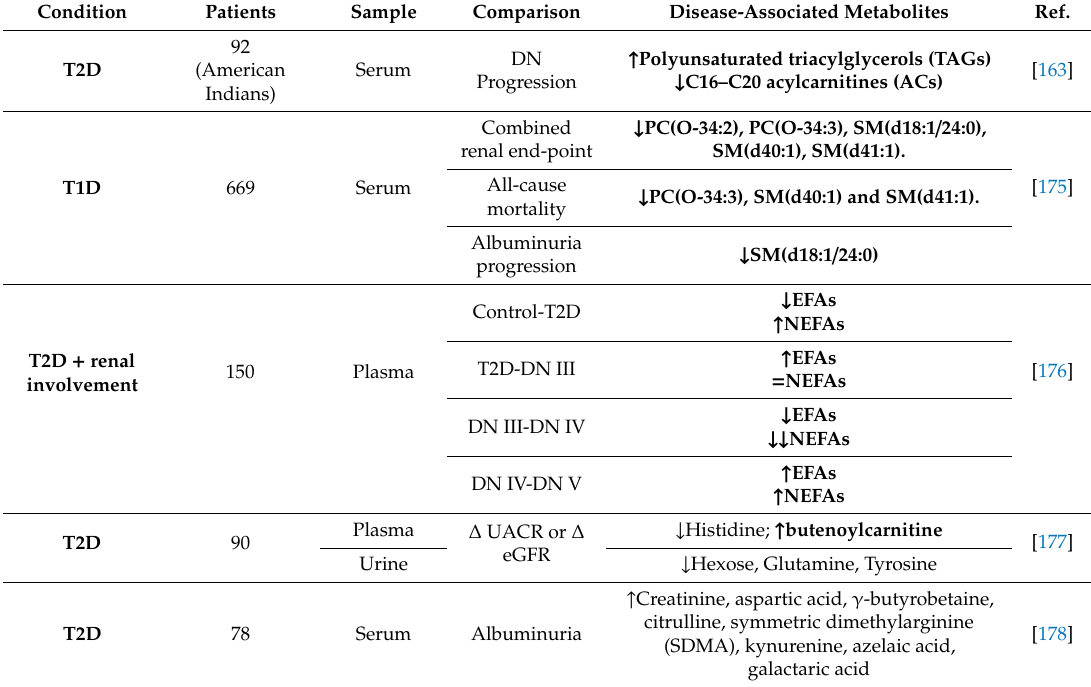
Table 1. Selected articles on lipotoxicity-related biomarkers in diabetic nephropathy. Lipid metabolites are labeled in